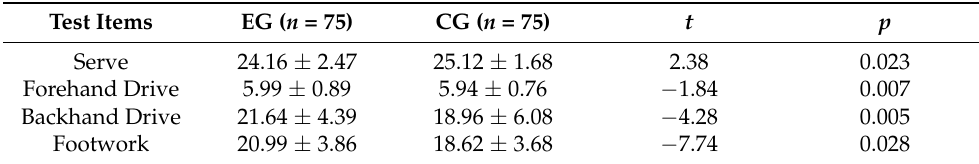
Table 12. Comparison of EG and CG based on Tennis Learning Performance after Experimen- tal